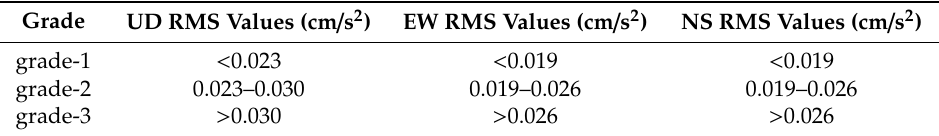
Table 1. Definition of RMS value classification for each GL-P2B station.